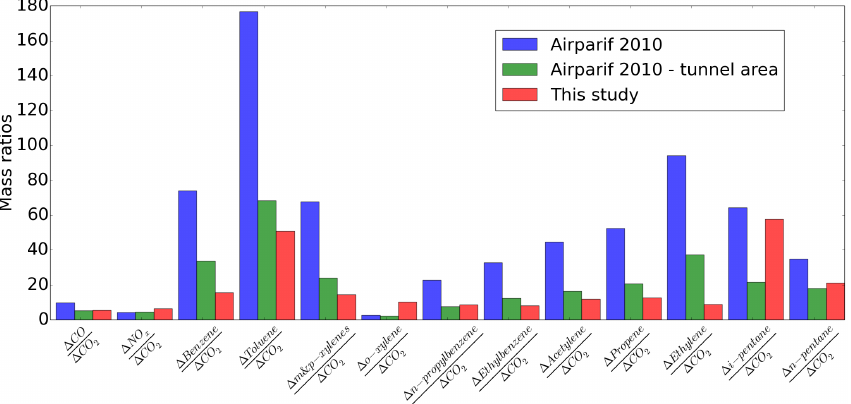
Figure 3. Comparison between observed ratios to CO 2 and emission ratios provided by the 2010 Airparif inventory for only the traffic source. In blue are the ratios from the Airparif inventory for the whole Île-de-France region; in green are the ratios from the Airparif inventory using emissions only in the tunnel area; in red are the ratios from our study. Ratios for CO and NO x are reported in tkt − 1 ; all others are reported in kgkt − 1 . Table 2. (cid:49) CO to (cid:49) CO 2 ratios for traffic emissions, comparison with previous studies (continued from Popa et al., 2014). Results of this study are shown in bold. Reference (cid:49) CO /(cid:49) CO 2